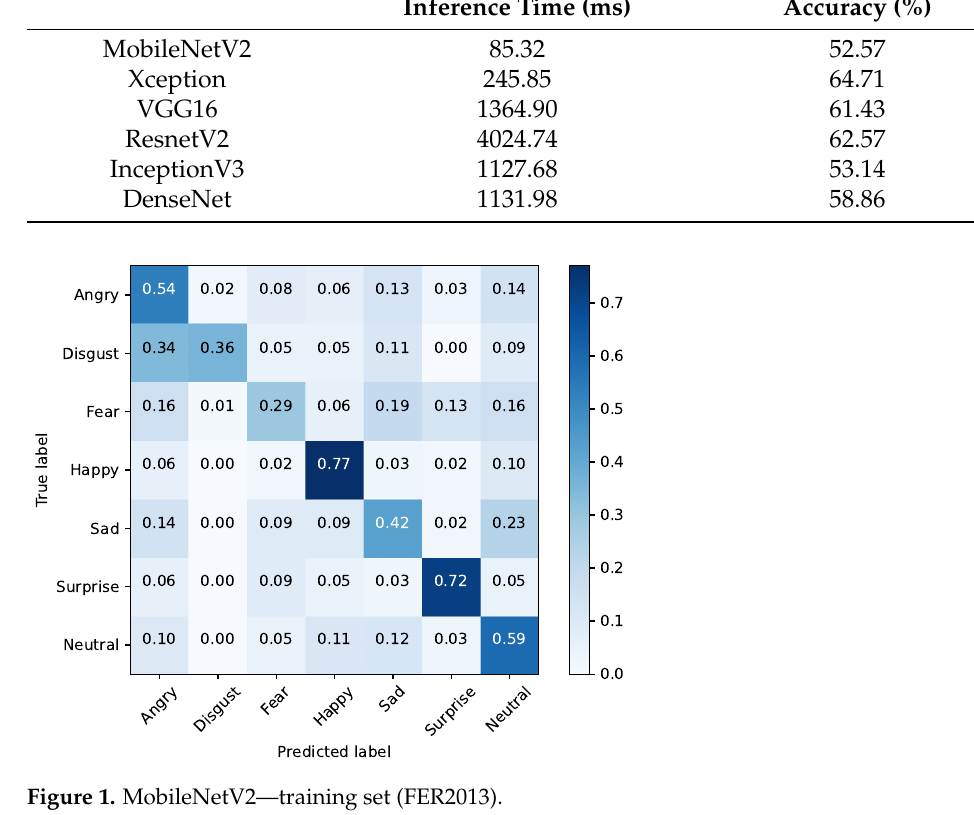
Figure 1. MobileNetV2—training set (FER2013).